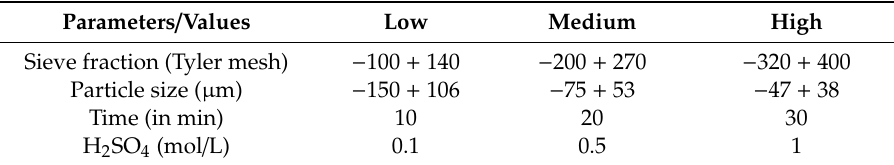
Table 4. Experimental